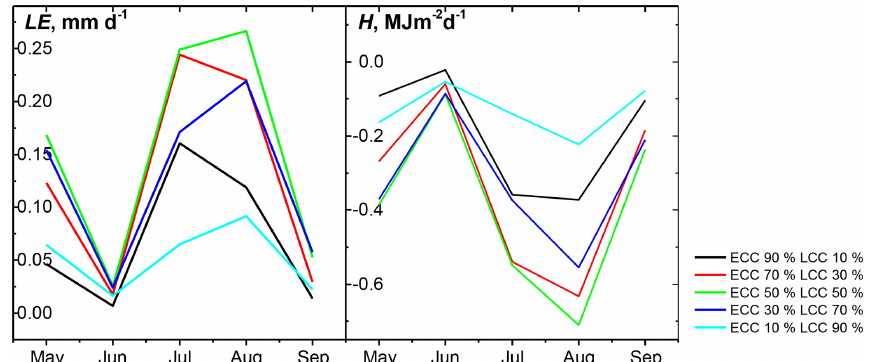
Figure 10. Differences in latent heat flux ( LE ) and sensible heat flux ( H ) between Run 1 and Run 2 simulations (Run 1–Run 2). Simulations were performed considering different shares of ECC and LCC.